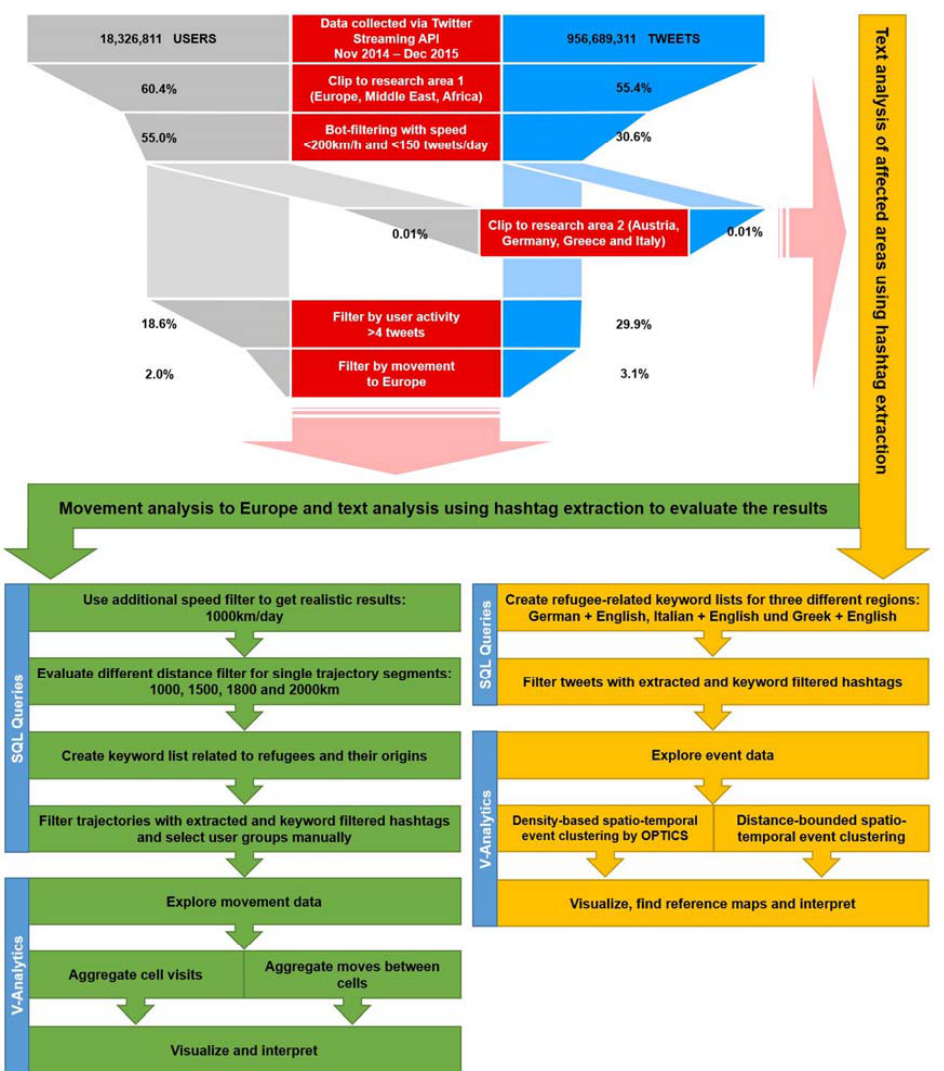
Figure 3. Conceptual analysis model of data filtering and processing.